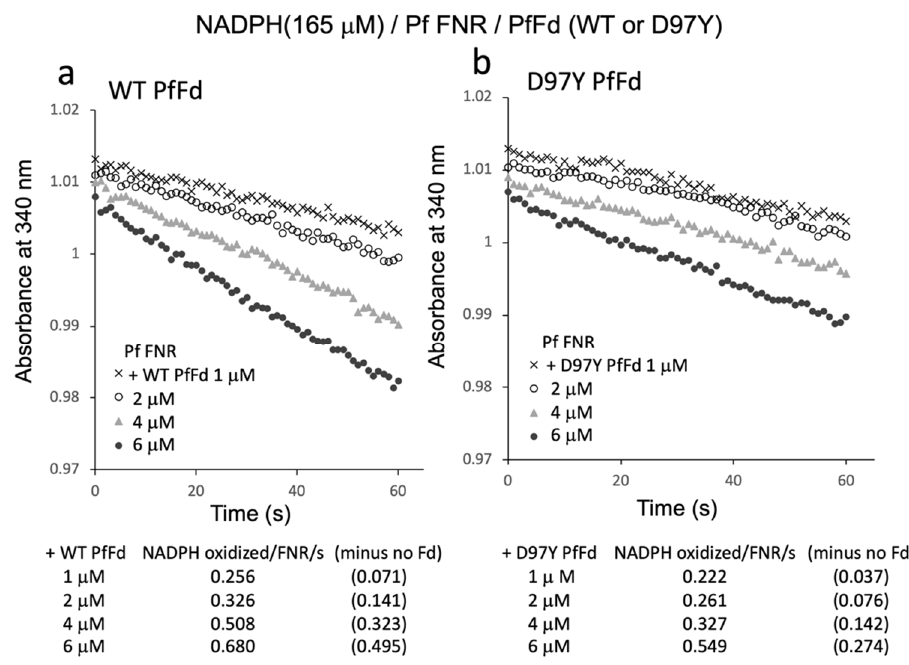
Figure 5. NADPH oxidation by PfFNR with different concentrations of wild-type ( a ) or D97Y PfFd ( b ). The activity was measured under 165 µM NADPH. The values in parentheses are the values after subtracting the activity in the absence of Fd (0.185 NADPH oxidized/FNR/s).